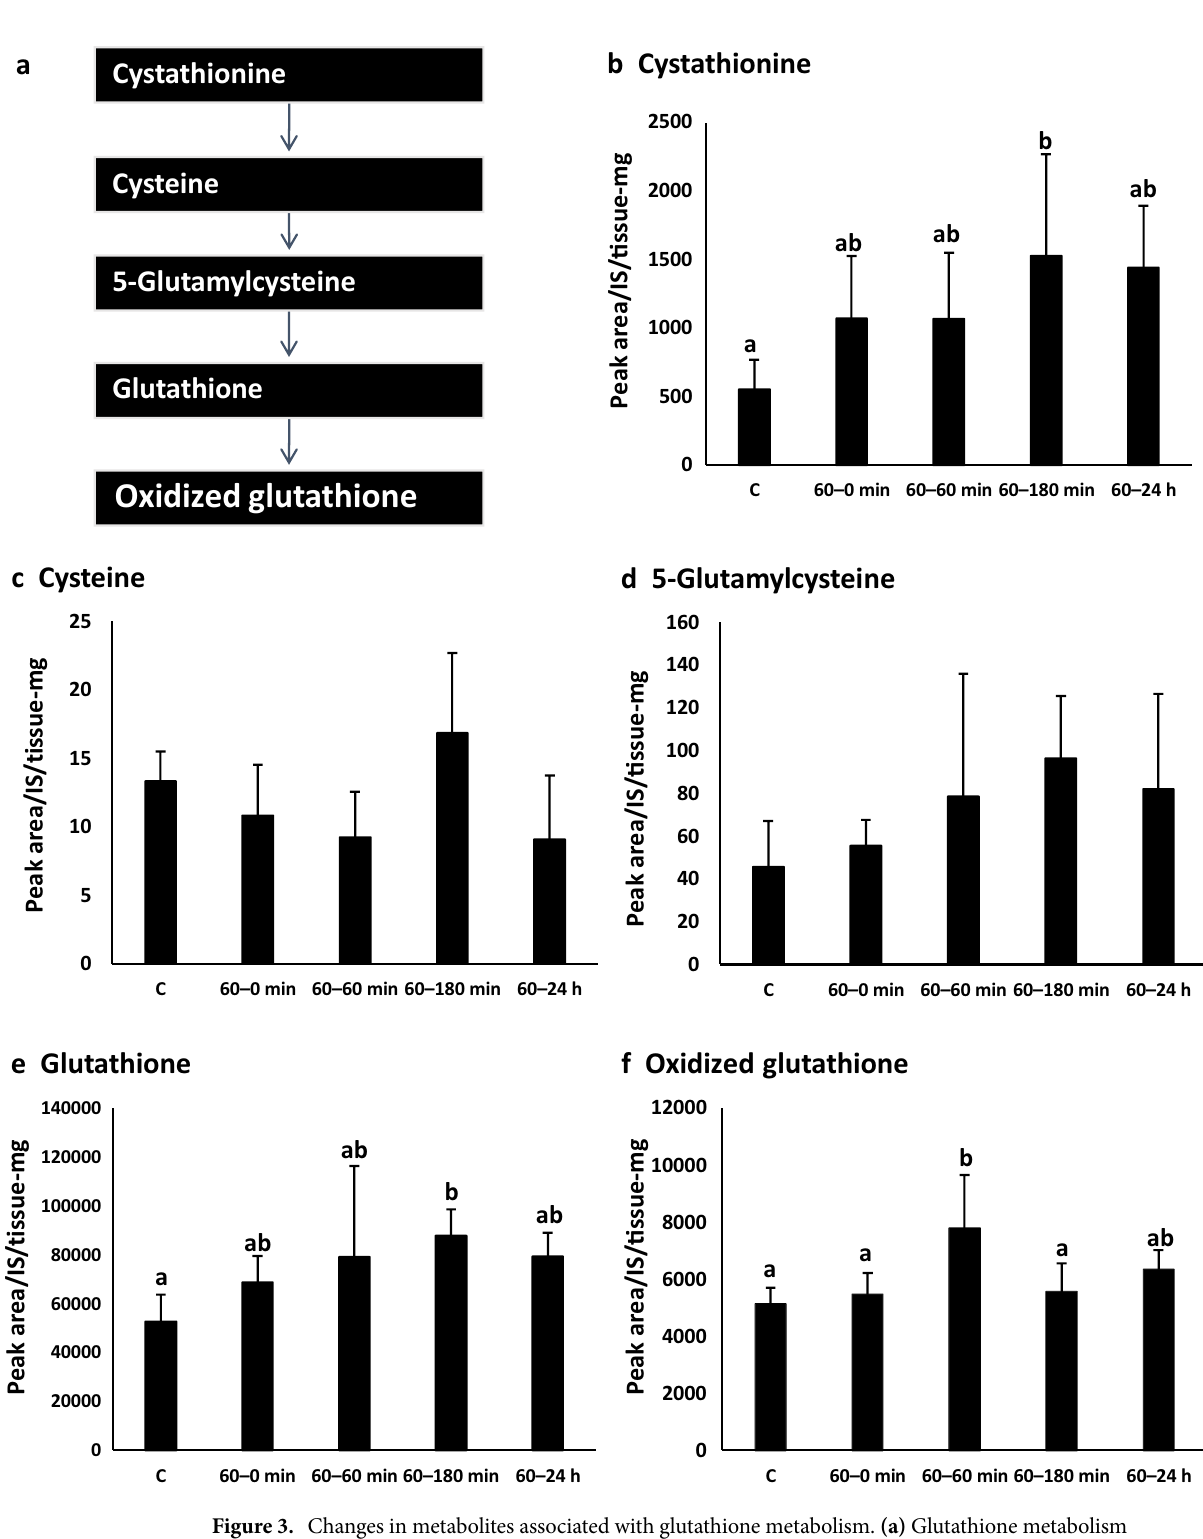
Figure 3. Changes in metabolites associated with glutathione metabolism. (a) Glutathione metabolism pathway, (b) cystathionine, (c) cysteine, (d) 5-glutamylcysteine, (e) glutathione, (f) oxidized glutathione. C group (n = 7), 60–0 min group (n = 6), 60–60 min group (n = 6), 60–180 min group (n = 6) and 60 min-24 h group (n = 6). Values with different letters are significantly different (p <